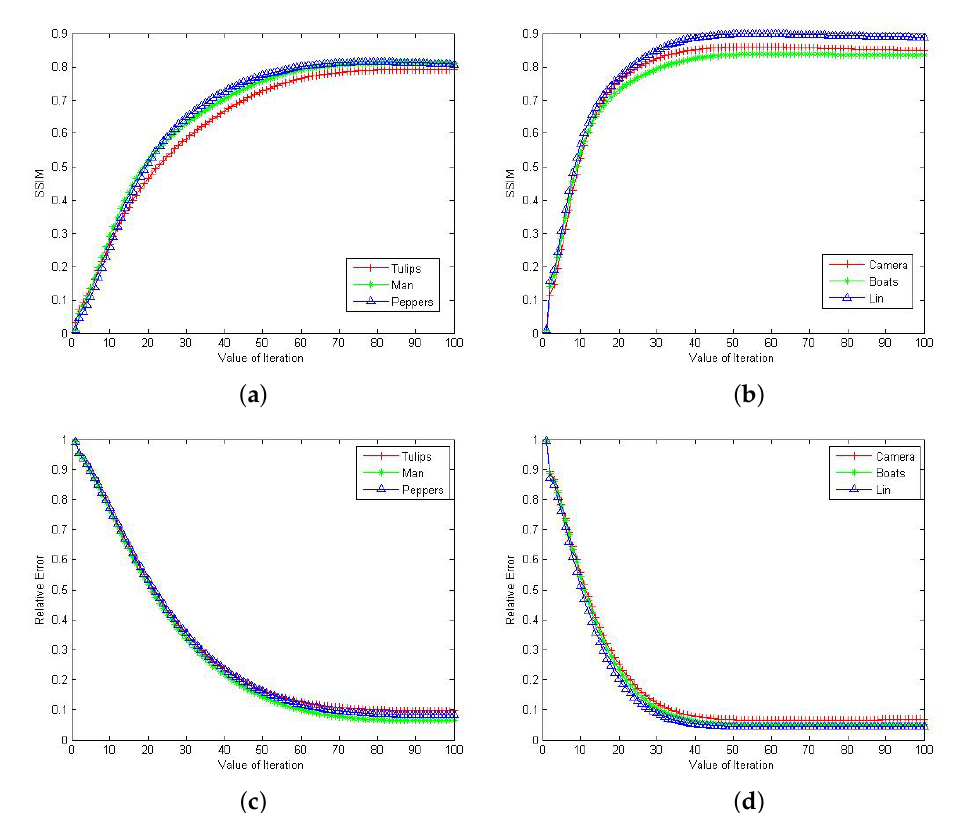
Figure 10. The SSIM and the ReErr values versus iteration in our model for different images with different noise levels: ( a ) L = 20. ( b ) L = 30. ( c ) L = 20. ( d ) L =